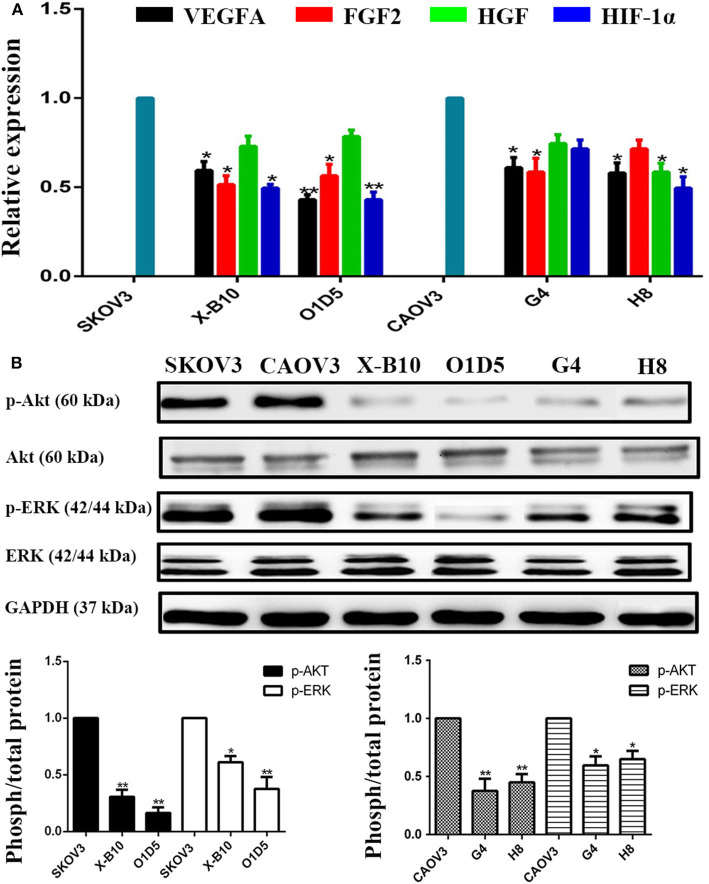
OC-2 KO down-regulated the expression of pro-angiogenic growth factors and the activation of Akt/ERK pathways in SKOV3 and CAOV3 cells. (A) qPCR analysis of expression levels of VEGFA, FGF2, HGF, and HIF-1α in X-B10, O1D5, G4, and H8 cells. (B) Western blotting analysis of the Akt/ERK pathways expression status in X-B10, O1D5, G4, and H8 cells. GAPDH served as loading control. The signal intensities were analyzed by ImageJ software. *P < 0.05, **P < 0.01.